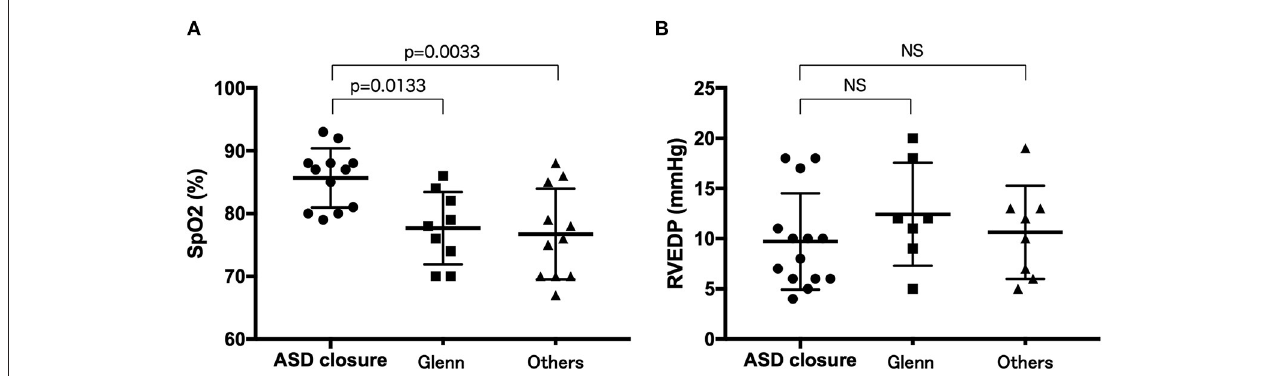
FIGURE 2 | Comparison of arterial oxygen saturation (A) and right ventricular end-diastolic pressure (B) between the patients who underwent ASD closure, Glenn operation, or one and a half ventricular repair and those who did not underwent surgery. ASD closure patients who underwent ASD closure, Glenn patients who underwent Glenn operation or one and a half ventricular repair, others patients who did not undergo surgery.